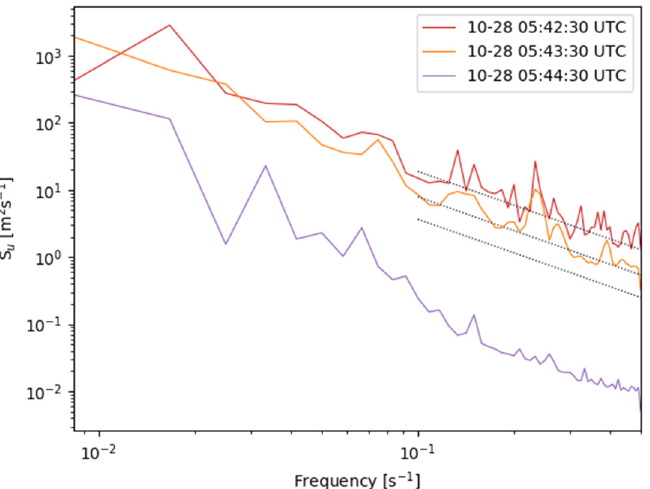
Figure 4. The power spectral densities (PSDs) of the zonal wind calculated from the quick access recorder (QAR) data at 05:42:30, 05:43:30, and 05:44:30 UTC on 28 October 2018. Dotted black lines indicate the k -5/3 slope of the eddy dissipation rate (EDR) values matching 0.15, 0.22, and 0.34 m 2/3 s -1 (bottom to top), which correspond to the light (LGT), moderate (MOD), and severe (SEV) turbulence, respectively, for medium-size aircraft [3,28,38,42].